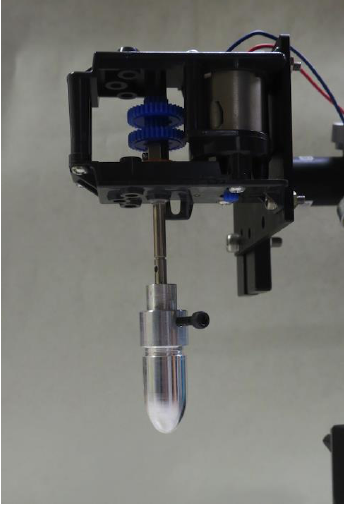
Figure 4. Rotational mechanism for rotational dipping.